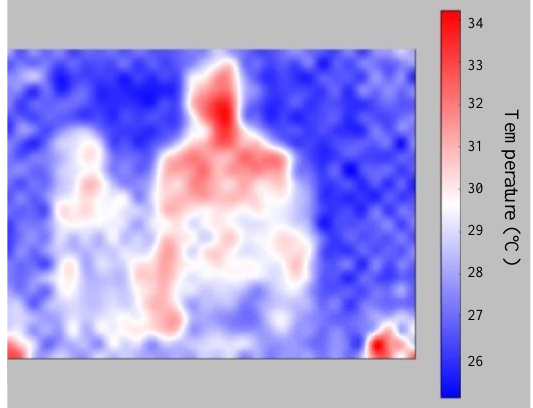
Figure 29. Current heat map in real time.